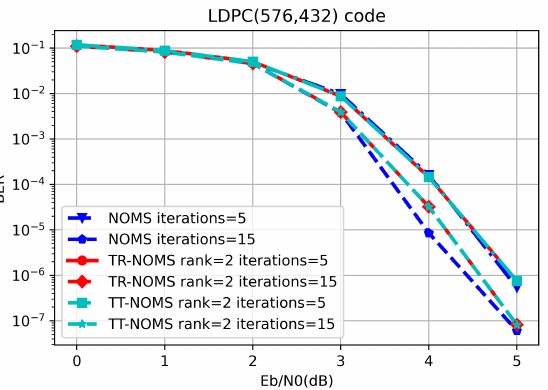
Figure 11. BER performance of TT-NOMS TR-NOMS and NOMS [22] algorithms for LDPC(576,432) code with 5 and 15